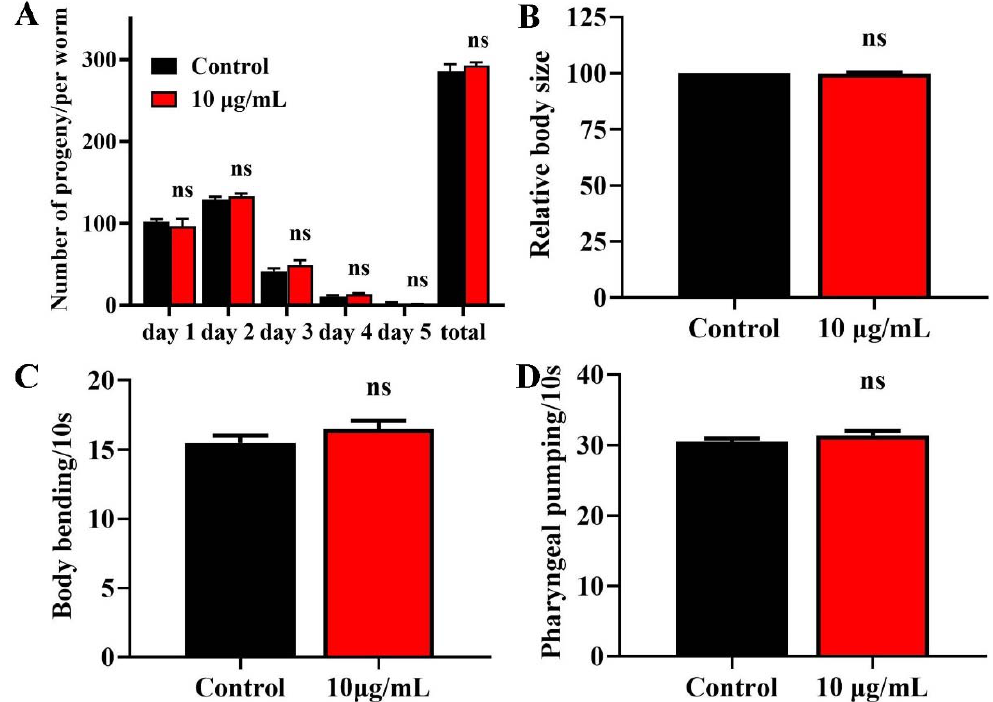
Figure 2. Effects of TG on the breeding population, body size, body bending and pharyngeal pumping in C. elegans . ( A ) Breeding of C. elegans treated with or without TG. The number of eggs were monitored on day 1 of adulthood until day 5. ( B ) Worms treated with TG showed no significant changes in body size. ( C ) Worms treated with TG showed no significant changes in body bending. ( D ) Worms treated with TG showed no significant changes in pharyngeal